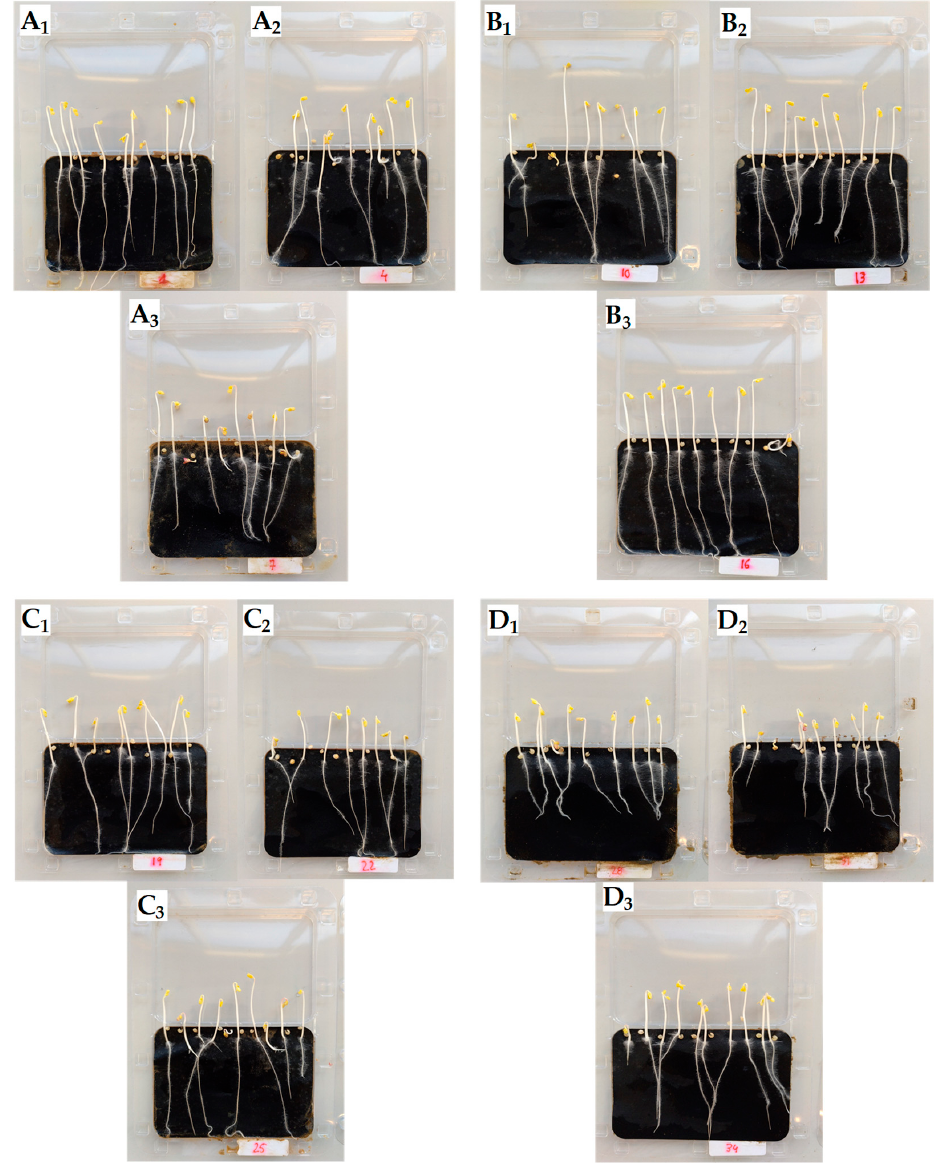
Figure 1. Toxicity/tolerance bioassays (examples) with S. alba for the control soil and different soil treatments: Without nanoparticles—( A 1 ) Control soil, ( A 2 ) Soil + Cd (1 mg kg − 1 ), ( A 3 ) Soil + Cd (3 mg kg − 1 ); With HANPs ( B 1 ) Soil, ( B 2 ) Soil + Cd (1), ( B 3 ) Soil + Cd (3); With MNPs ( C 1 ) Soil; ( C 2 ) Soil + Cd (1); ( C 3 ) Soil + Cd (3); With FeNPs ( D 1 ) Soil; ( D 2 ) Soil + Cd (1); ( D 3 ) Soil + Cd (3).